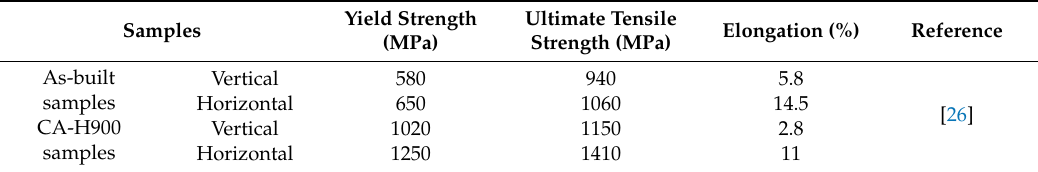
Table 7. The e ff ect of build orientation on the mechanical properties (material: 17–4 steel). Samples